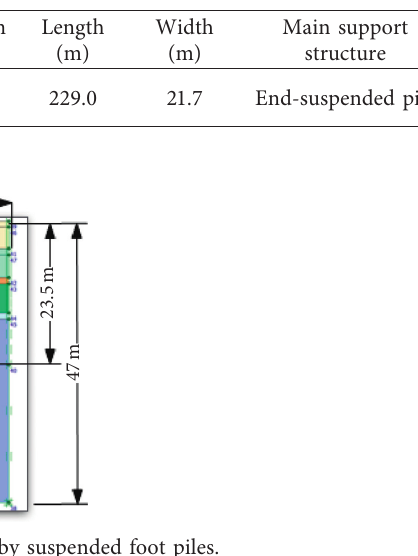
Table 1: General situation of the subway station foundation pit.